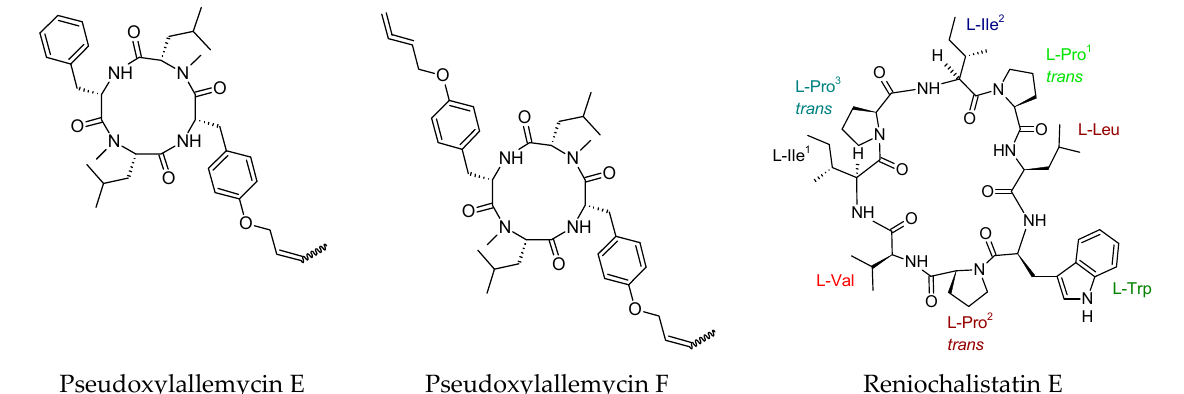
Figure 4. Recently isolated anticancer cyclic peptides.